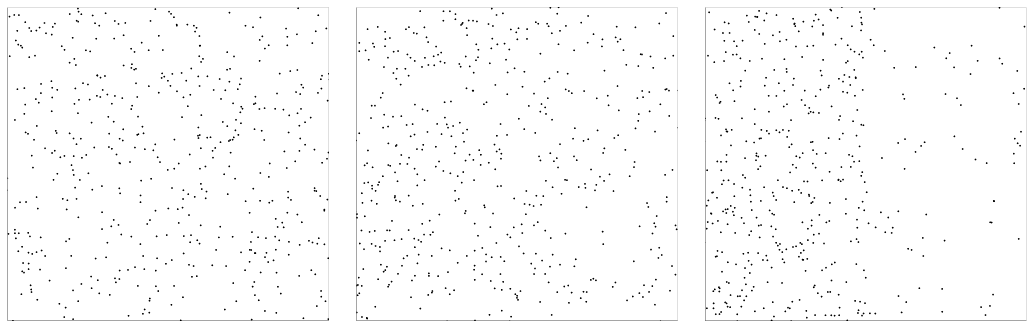
Figure 1 . Typical simulated point data sets used in our studies of straight-line boundaries. Here we show N = 500 points within the unit square, distributed according to: background only (left panel); background with an additionally injected signal (2.3) in the left half-plane with ρ = 1 . 5 (middle panel) or ρ = 5 (right